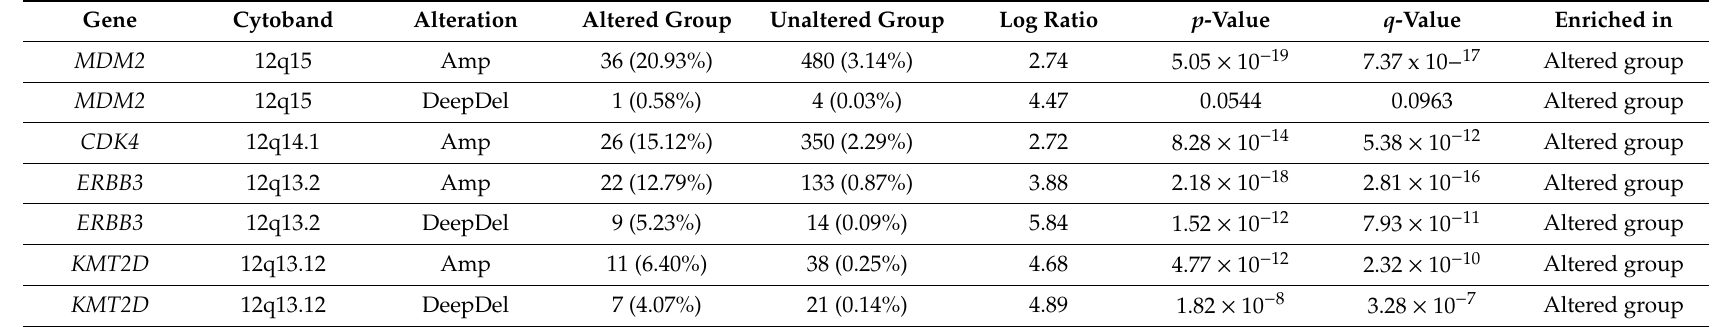
Table 2. Genes located in 12q12-12q15 for which CNVs are associated with cancer, and correlation with LRRK2